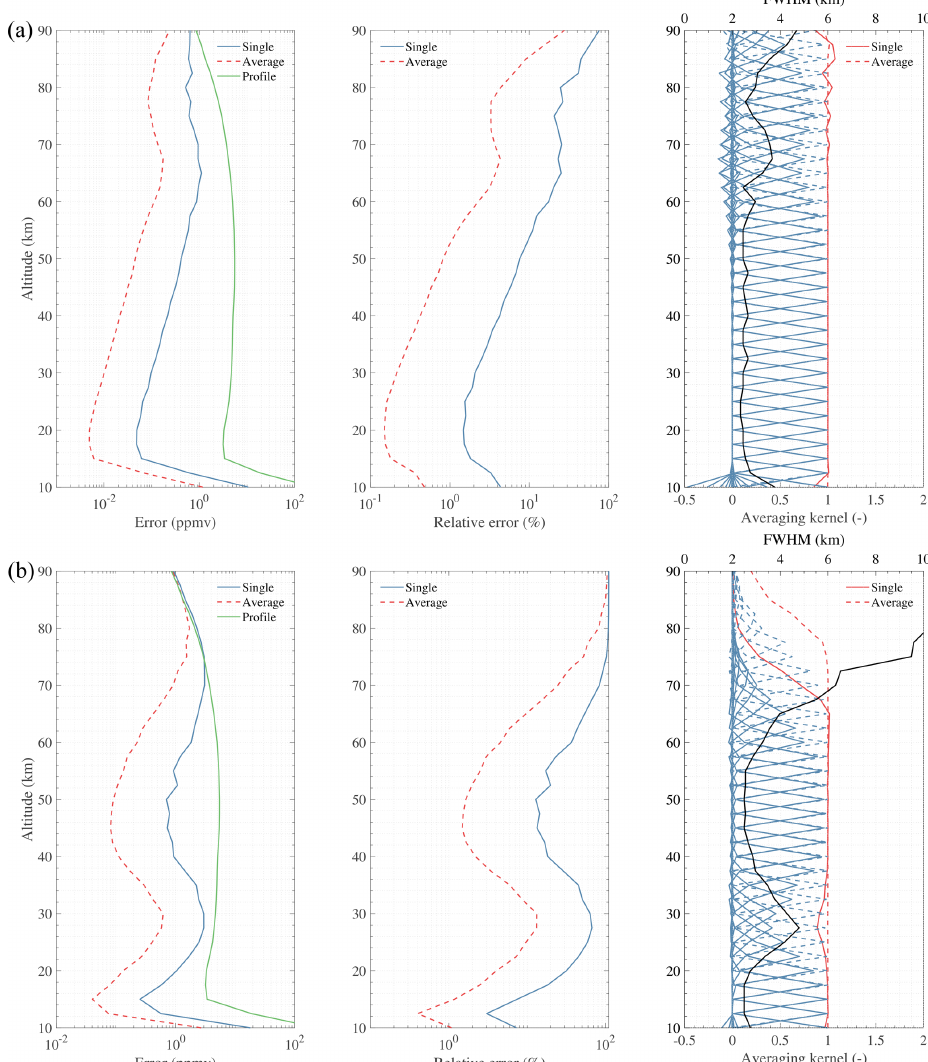
Figure 13. Simulation results of H 2 O retrieval using 183.31 (a) and 657.9GHz (b) lines. “Single” and “Average” represent the retrieval error using different noise. “Profile” represents the typical profile used in the simulation. The black solid line in the last panel represents the FWHM (i.e. vertical